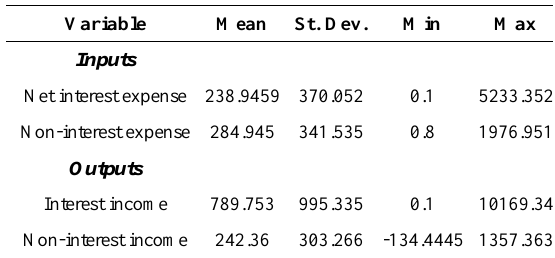
Table 2. Summary statistics of inputs and outputs (in Million